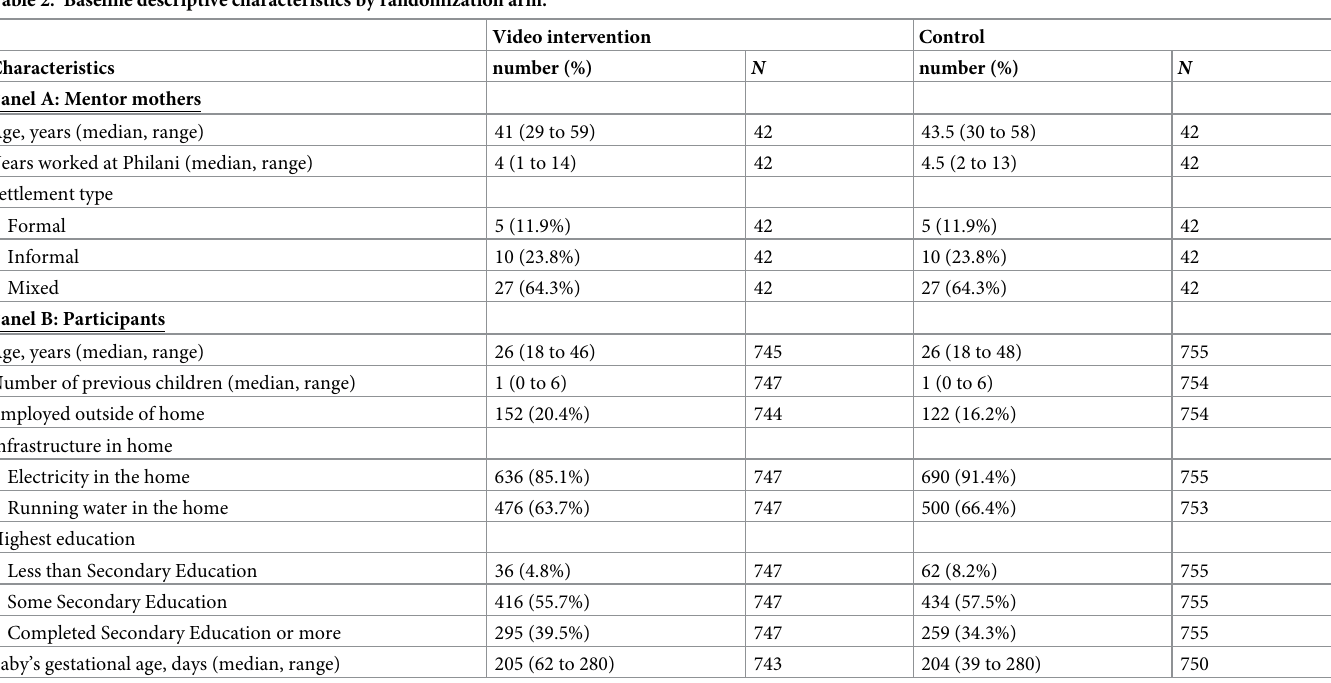
Table 2. Baseline descriptive characteristics by randomization